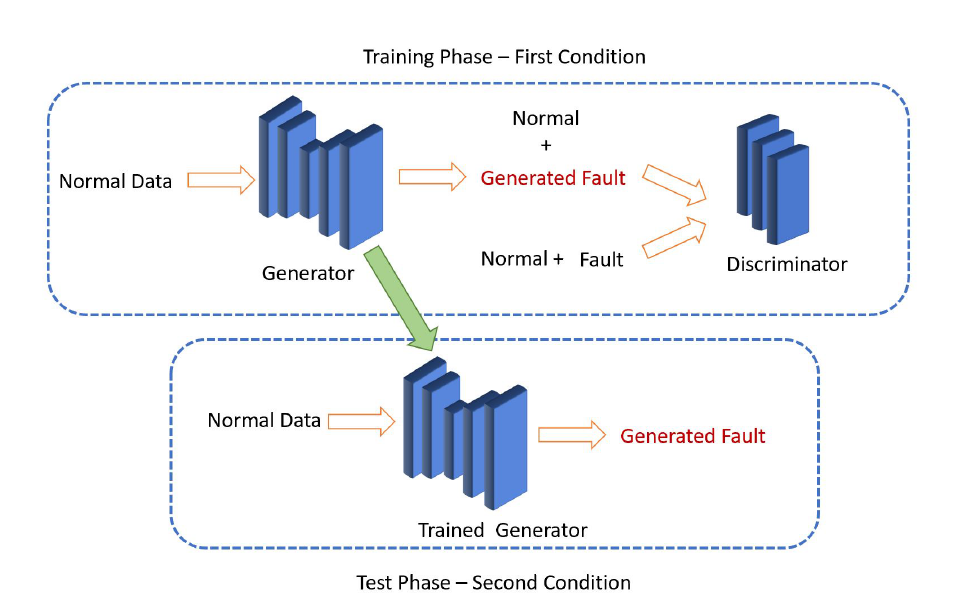
Figure 5. The proposed data generation framework (N2FGAN).